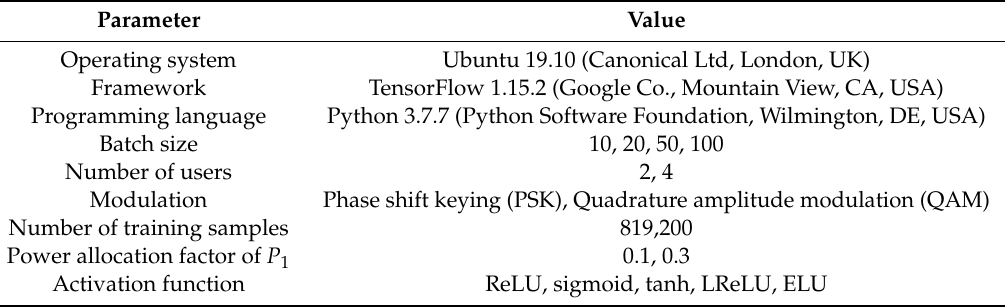
Table 1. Parameter settings used in the simulations.